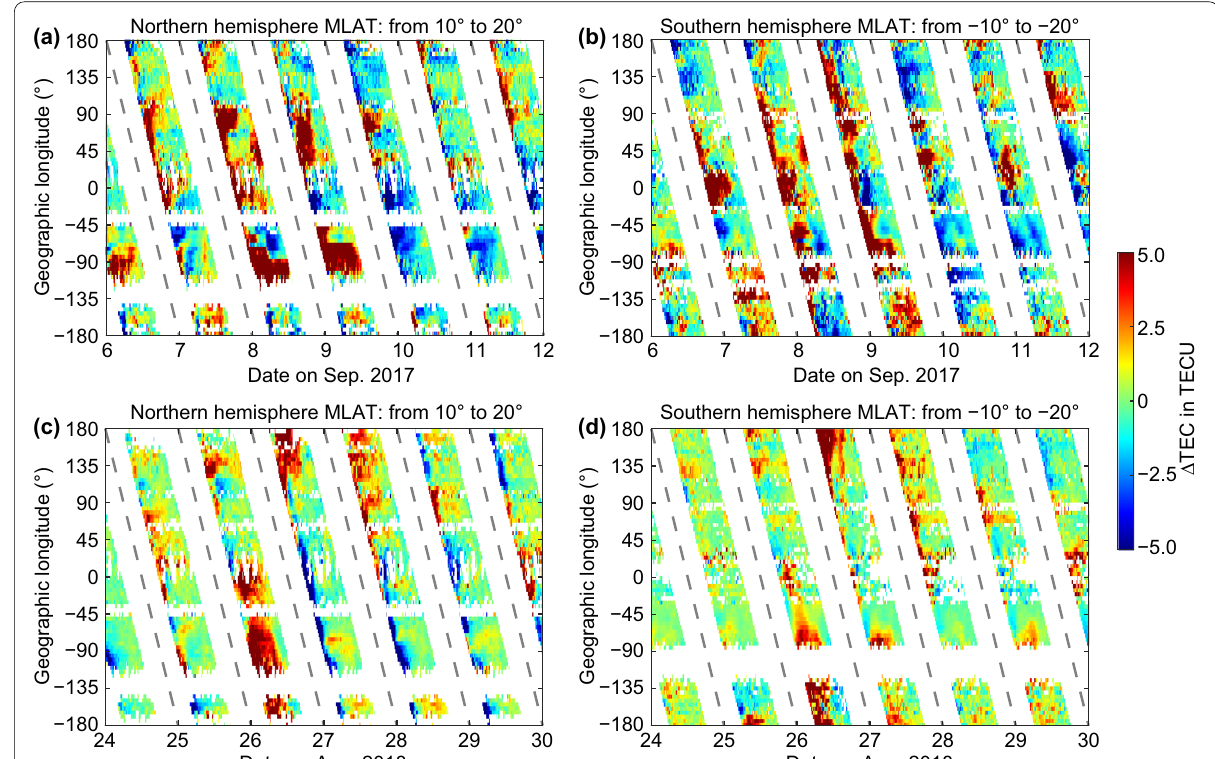
Fig. 3 As the same format as that in Fig. 2, but the ∆TEC at daytime (06:00–18:00 LT) is set as blank to emphasize the nighttime ∆TEC